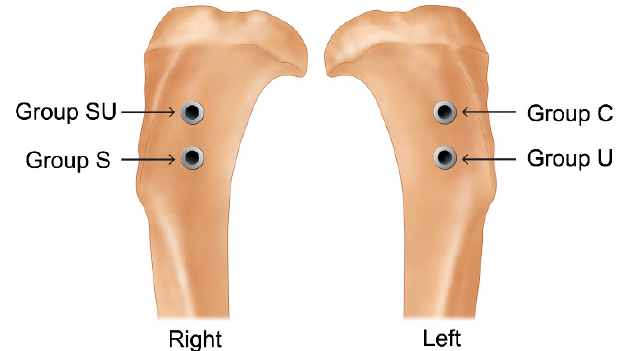
Figure 2. Implantation sites of four implants on the right and left proximal tibial metaphysis in a